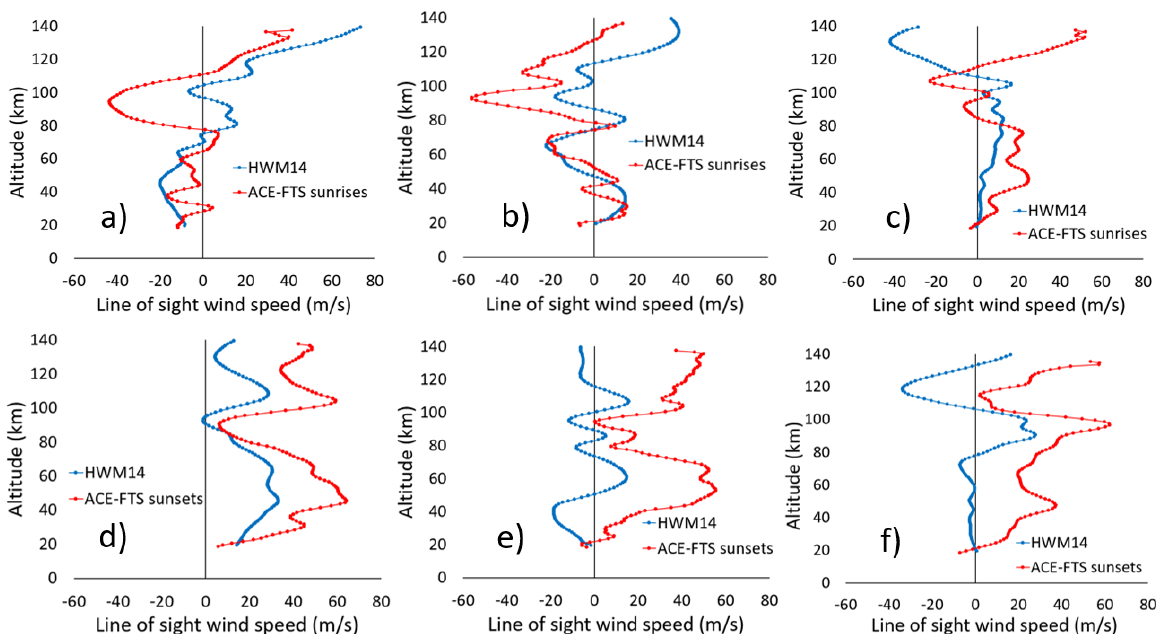
Figure 7. Comparisons between average line-of-sight wind profiles from the ACE-FTS (in red) and the average results from the Horizontal Wind Model 2014 (in blue) calculated at the ACE-FTS occultation times and locations from January to July 2020. ( a ) Southern (latitude < 45° S) ACE-FTS sunrises, the average of 544 profiles. ( b ) Tropical and subtropical (30° S to 30° N) sunrises, 208 profiles. ( c ) Northern (latitude > 45° N) sunrises, 371 profiles. ( d ) Southern sunsets, the average of 879 profiles. ( e ) Tropical and subtropical sunsets, 213 profiles. ( f ) Northern sunsets, 304 profiles.